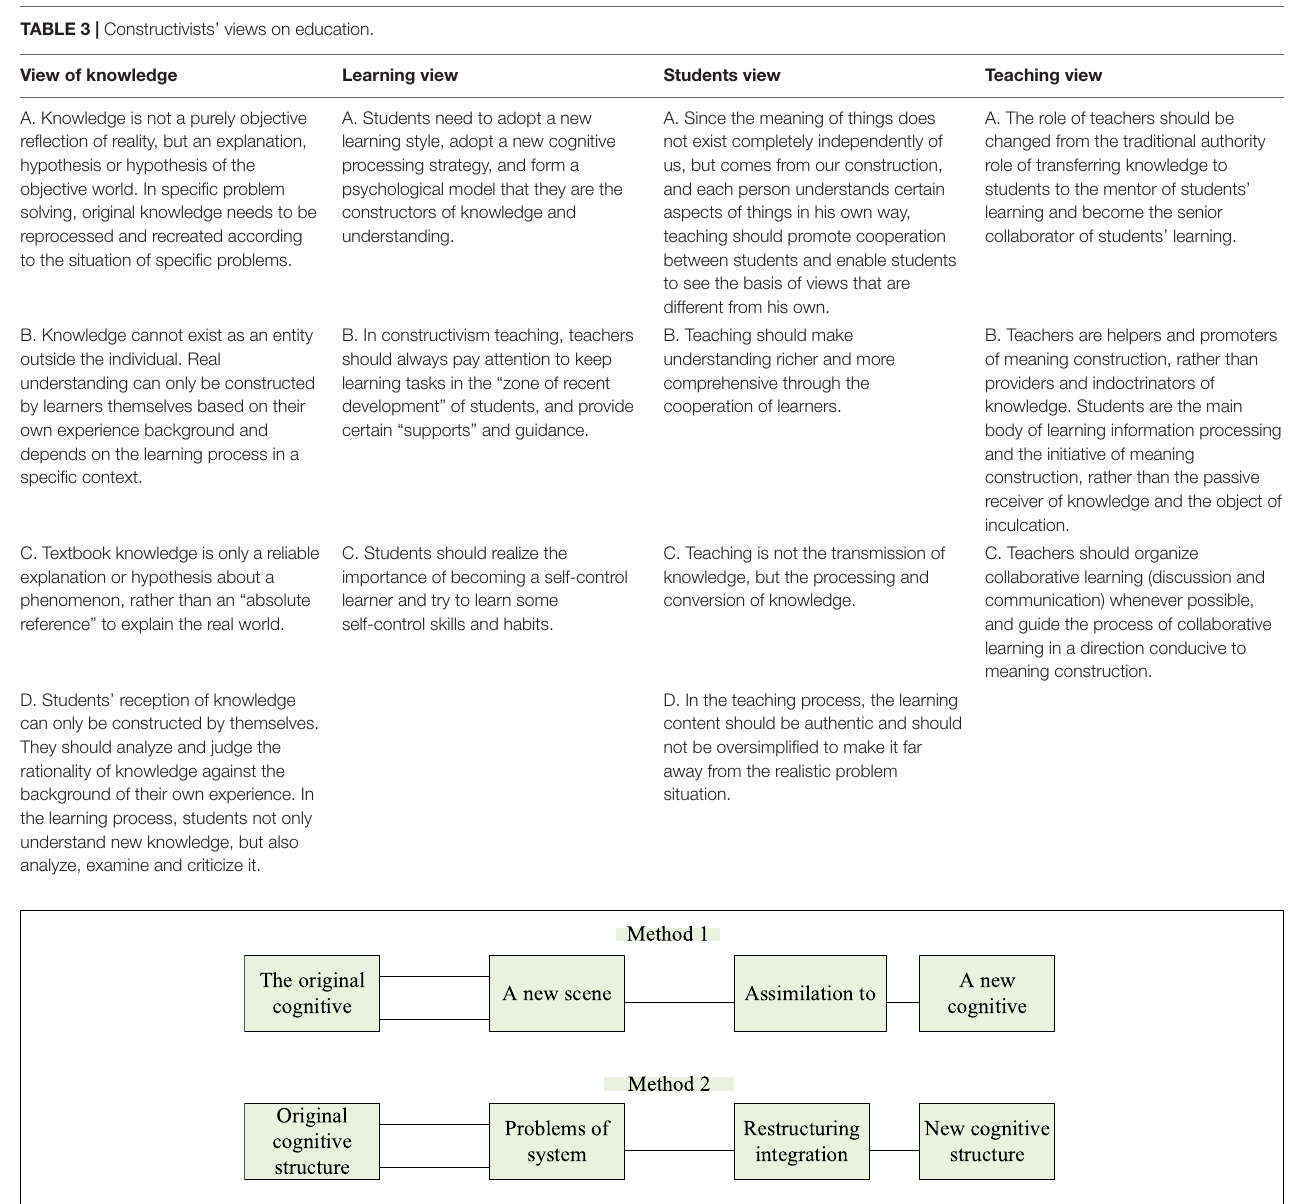
FIGURE 4 | Cognitive construction